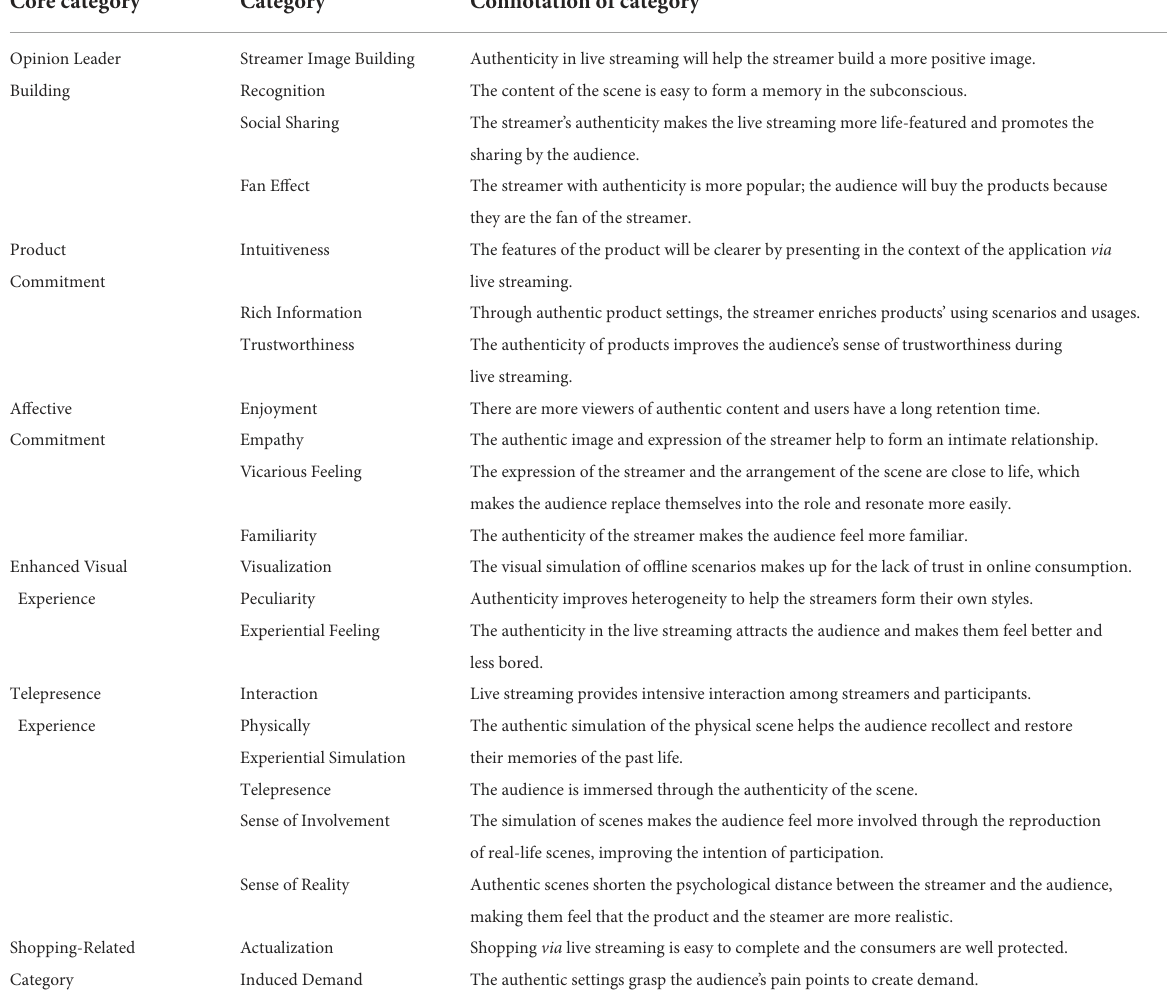
TABLE 3 The core categories and connotations associated with